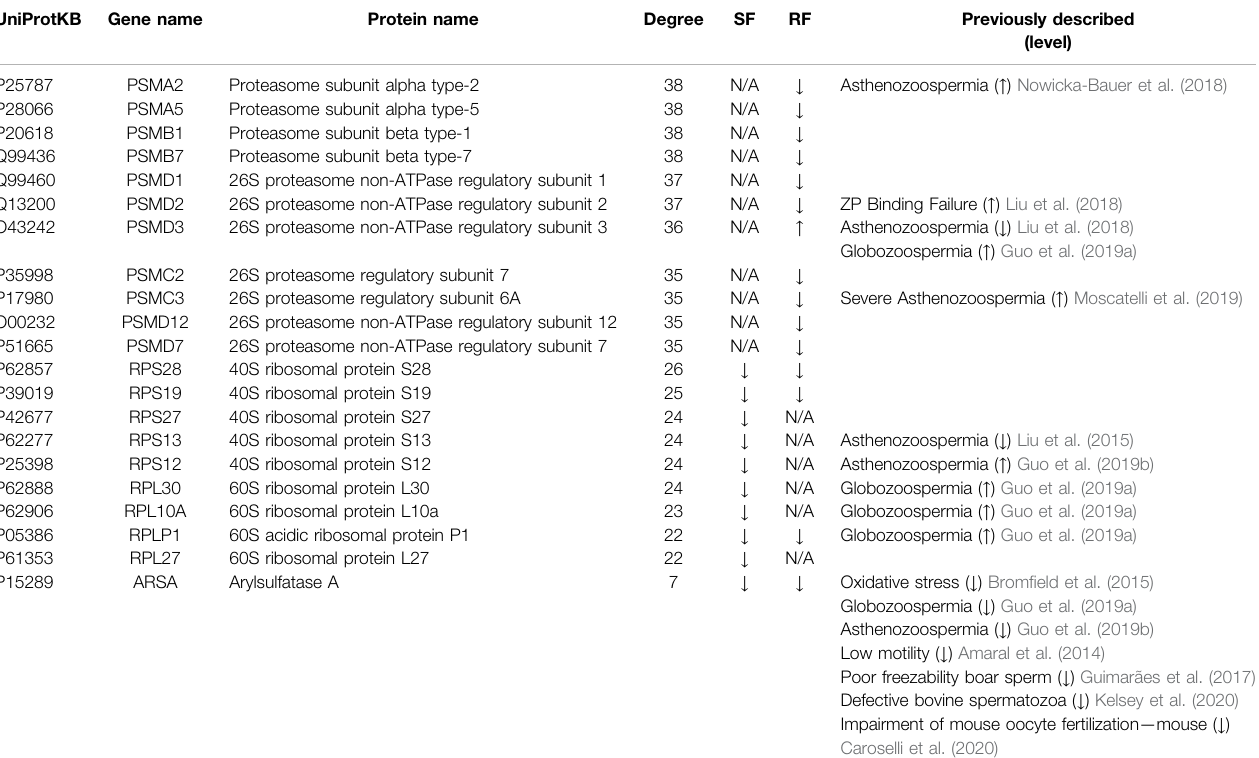
TABLE 1 | Protein hubs identi fi ed in each integrative protein-protein interaction network: Slow Freezing (SF) and Rapid Freezing (RF). Node degree (computed in the respective network) and expression level (up or down) for each protein are indicated. Previous studies concerning expression levels of these proteins in conditions associatedwithpoor-spermqualityarealsoindicated(studieswereperformedinhumanspermatozoa,exceptthosewherethespecieisindicated).ZP,ZonaPellucida;N/A, not applicable.